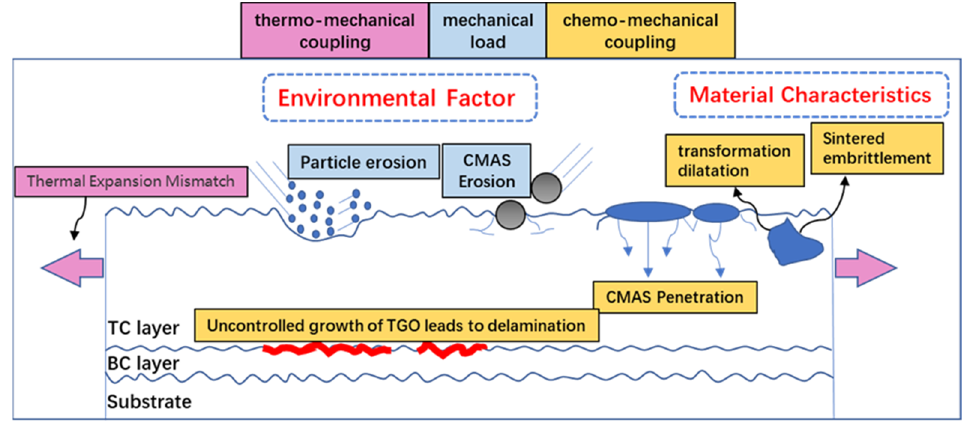
Figure 1. Diagram of coating failure.